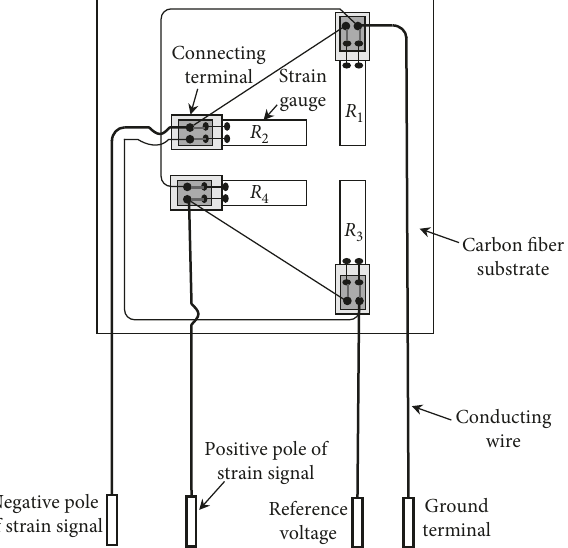
Figure 2: Schematic of the designed strain-gauge